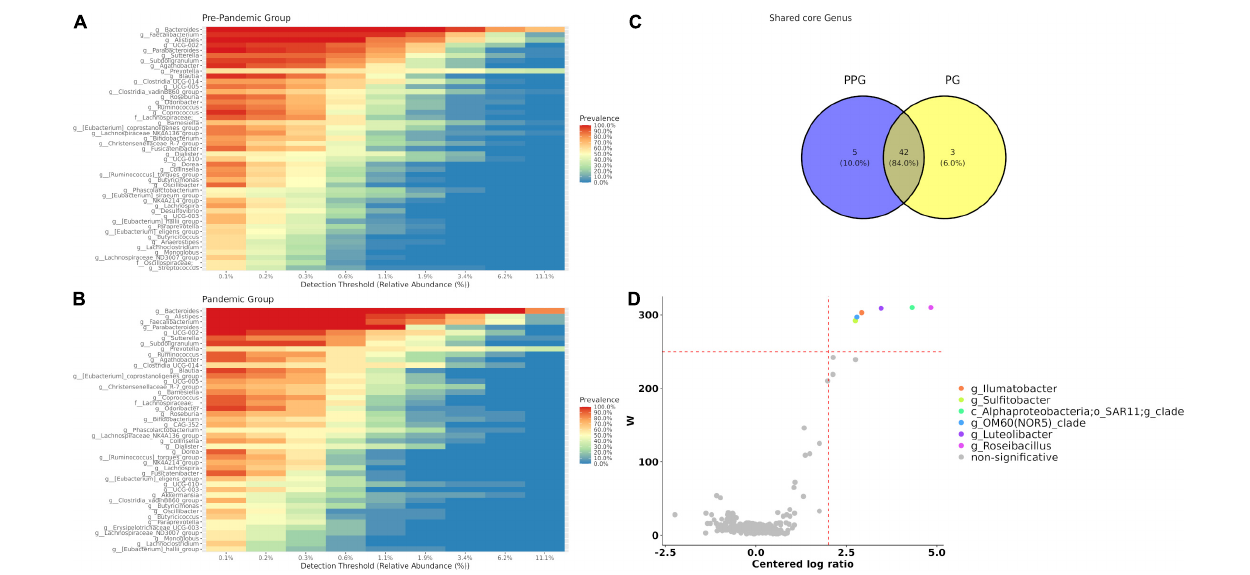
FIGURE 2 | Core microbiome for each group PPG (A) and PG (B) . (C) Venn diagram represents shared care genera between groups. Core genera were defined as 0.1% of detection and 50% of prevalence. (D) Volcano plot of the differentially abundant genera between PPG and PG patients. The W -value represents the number of times the null-hypothesis (the average abundance of a given feature in a group is equal to that in the other group) was rejected for a given feature. Red dash lines indicate a significance a priori threshold for differentially abundance set at W ≥ 248 ( W > 80% of the total number of genera) and clr (centered logarithmic ratio) > | 2|. Significant genera more abundant in PPG are represented in different colors; whereas non-significant genus are in gray.